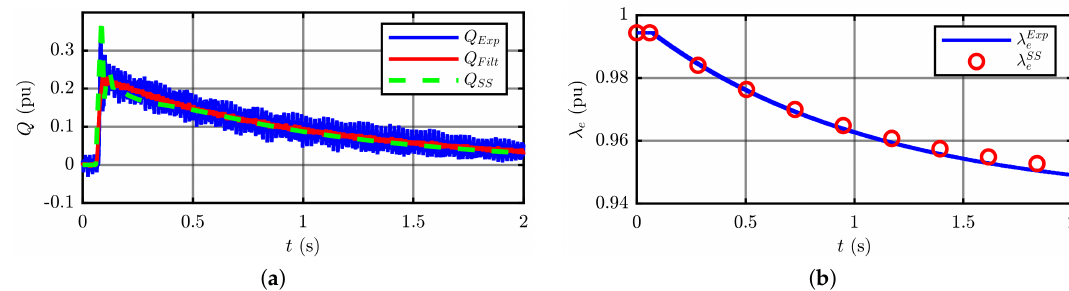
5 % with phase jump ∆ φ g = 5 ◦ . From left to right: − −